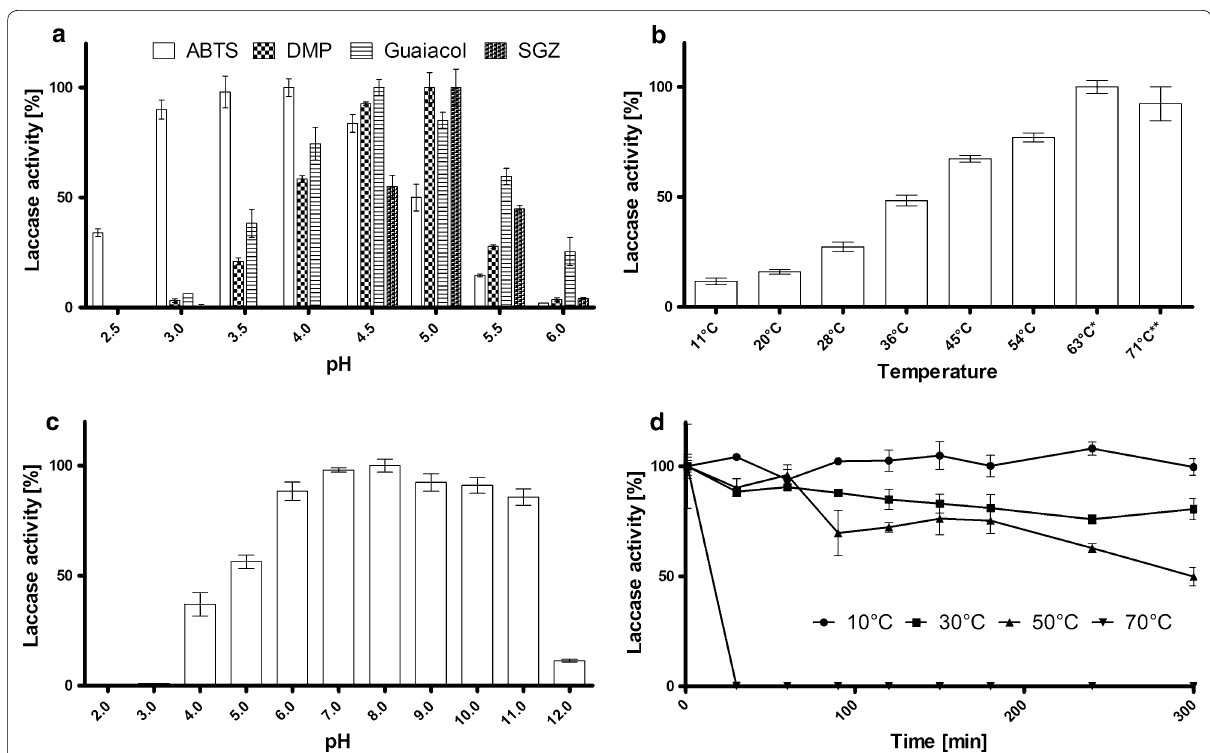
Fig. 4 Characterization of Lcc8. a Detection of substrate specificity and pH optimum. b Detection of optimal reaction temperature with ABTS. *The activity was stable for 5 min and then began to decrease slowly. **The activity was stable for 3 min and then began to decrease rapidly. c Analysis of optimal storage pH. d Enzyme stability at different